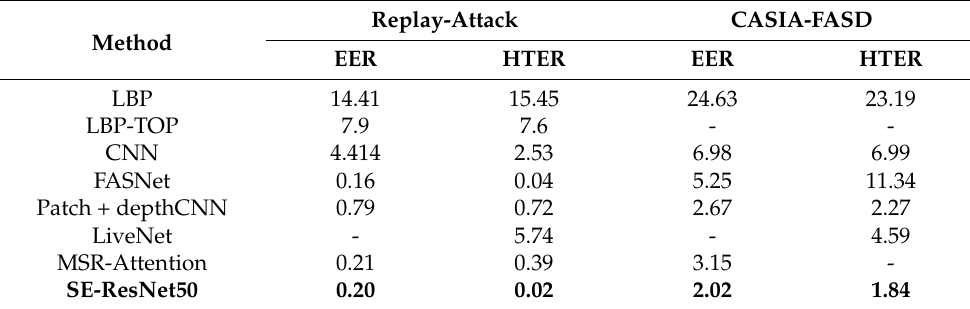
Table 3. Comparison table of results with existing methods.